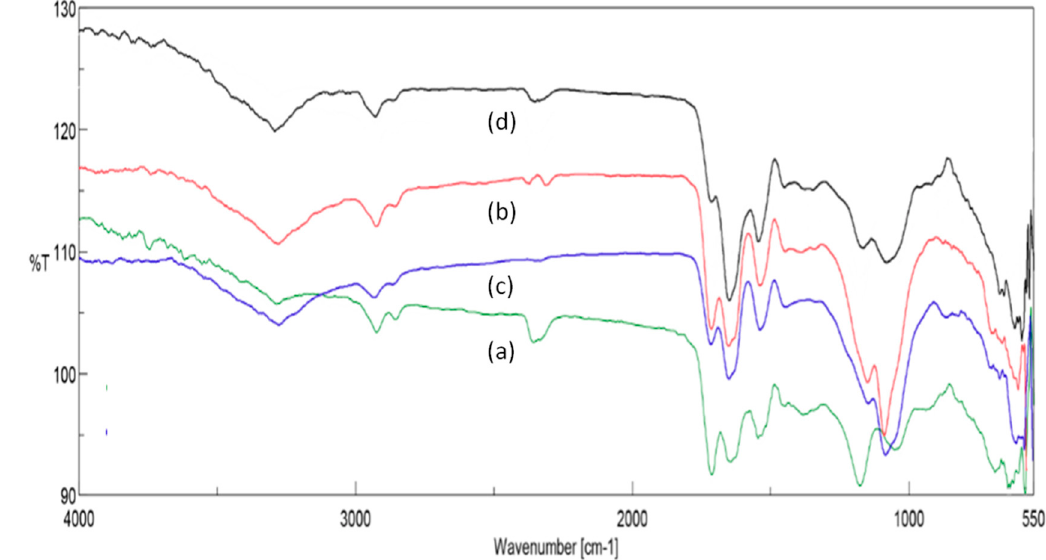
Figure 3. FT-IR spectra of bioplastic films from: ( a ) treated crude rapeseed cake; ( b ) defatted rapeseed cake powder; ( c ) deproteinized rapeseed cake; ( d ) defatted and deproteinized rapeseed cake.